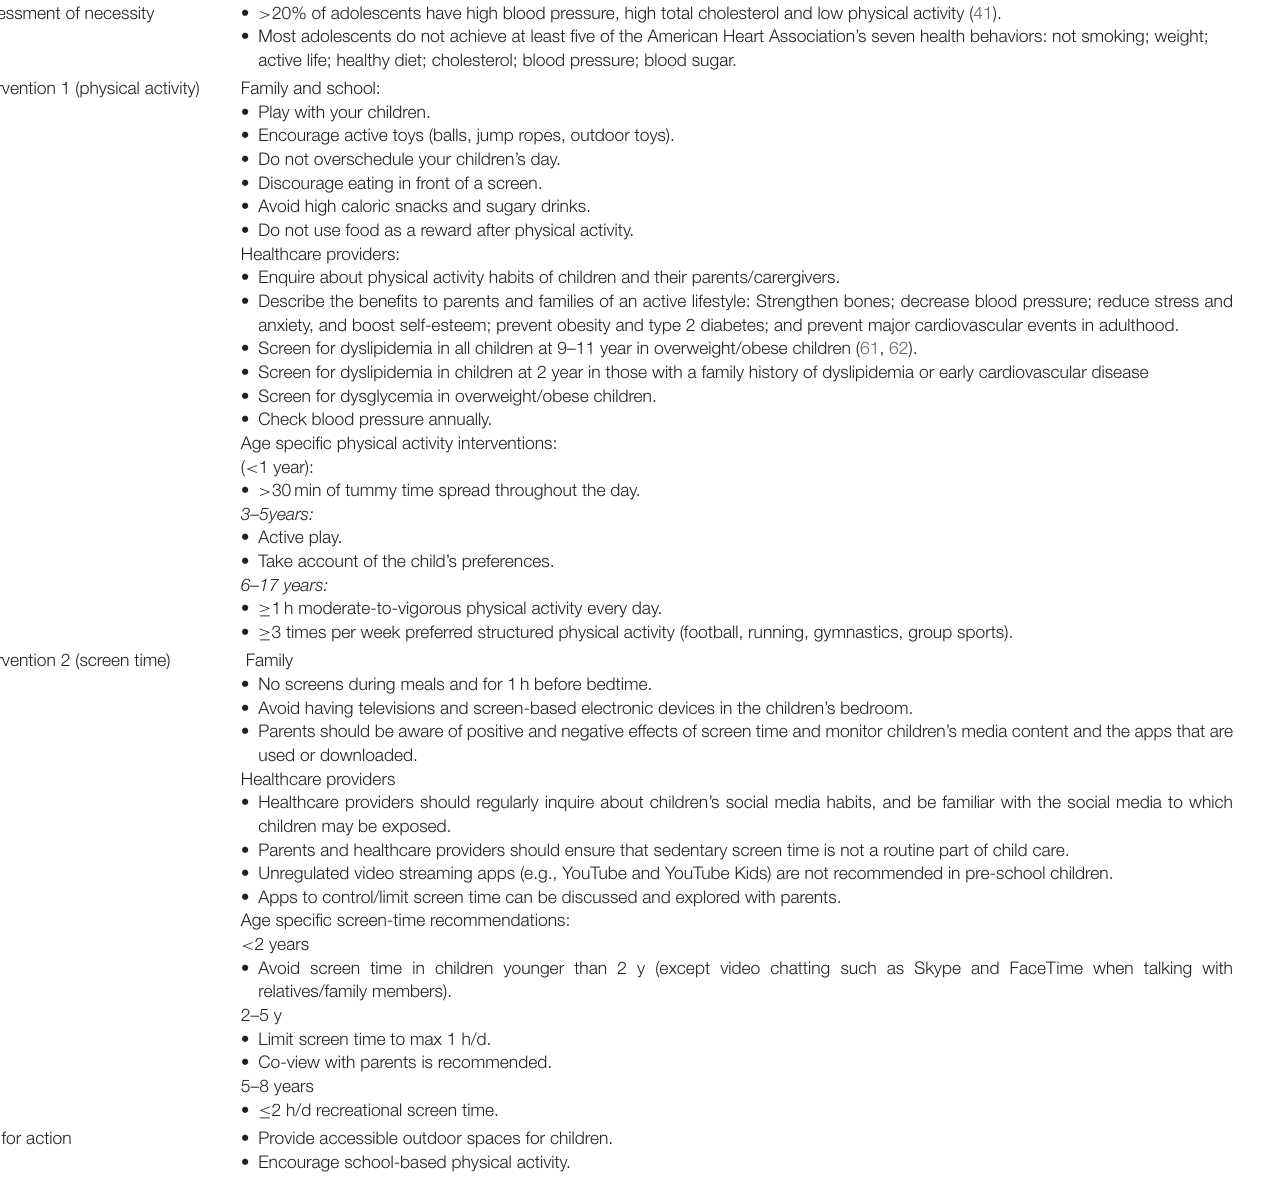
TABLE 2 | Cardiovascular health. Assessment of